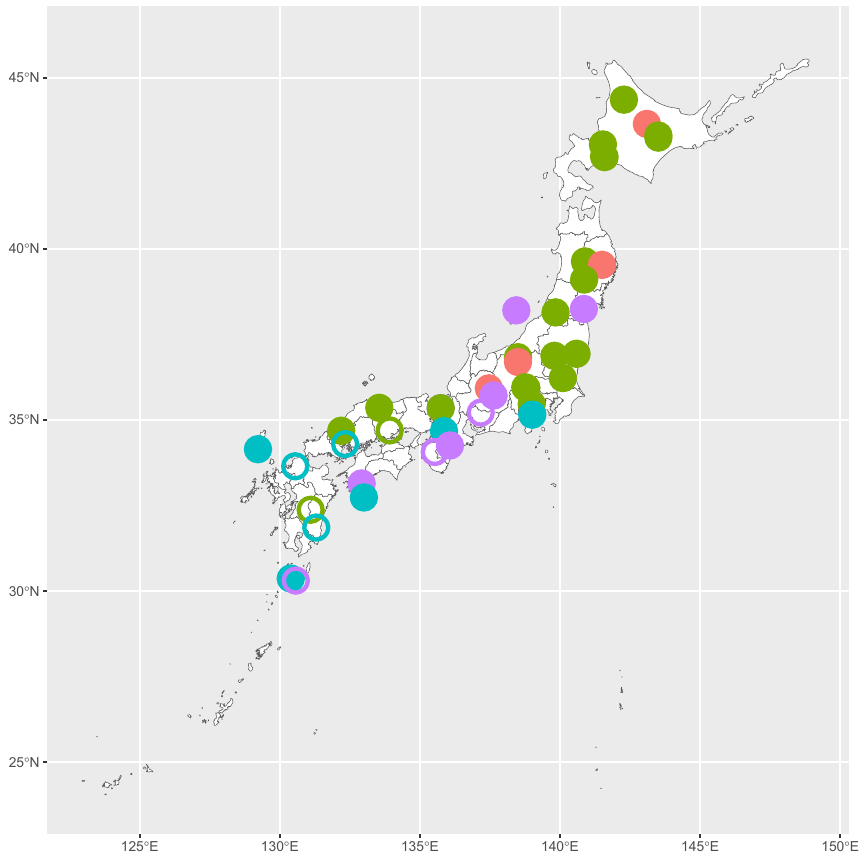
21, 9, and 8, respectively. The 42 plots included 32 old-growth forests, including 4 boreal conifer, 17 deciduous broadleaved, 6 temperate conifer, and 5 evergreen broadleaved plots. Plants of other types (e.g. bamboos) are very rare and negligible in these plots.